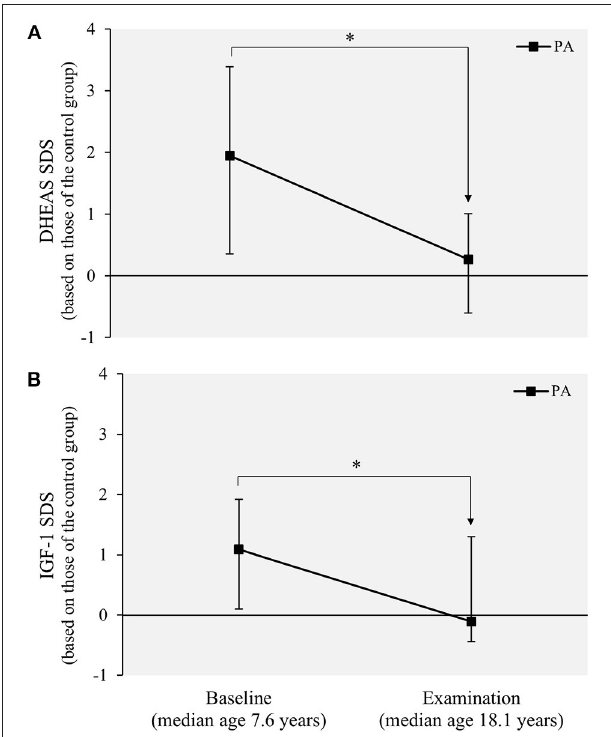
FIGURE 3 | Serum (A) DHEAS and (B) IGF-1 concentrations in the PA females ( n = 30) from prepuberty to adulthood. Values are expressed as median SDSs (25th − 75th percentiles) based on those of the control females ( n = 42). Statistical significance of the age-dependent change within each variable were analyzed using the Wilcoxon signed ranks test. * P = < 0.001. DHEAS, dehydroepiandrosterone sulfate; IGF-1, insulin-like growth factor 1; PA, premature adrenarche; SDS, standard deviation